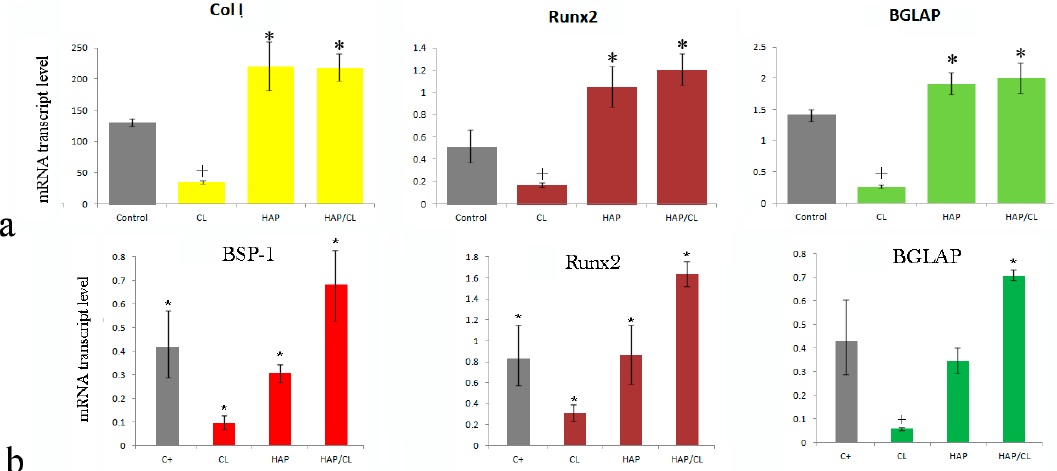
Figure 7. Gene expression of osteocalcin ( BGLAP ), the transcription factor Runx2 , type I procollagen ( Col I ) and osteopontin ( BSP-1 ) in osteoblastic MC3T3-E1 cells uninfected ( a ); or infected ( b ) with S aureus and treated with clindamycin (CL), hydroxyapatite nanoparticles (HAP) and hydroxyapatite nanoparticles loaded with clindamycin (HAP/CL). All data are represented as averages and were normalized to the expression of beta-actin ( ACTB ) as the housekeeping gene. Data points significantly different from the control ( p < 0.05) are topped with an asterisk (*).